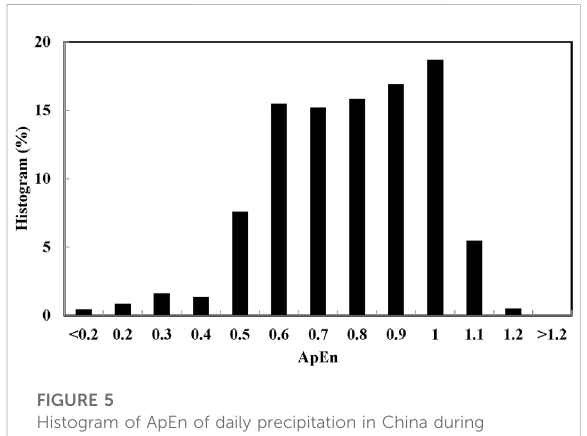
FIGURE 5 Histogram of ApEn of daily precipitation in China during 1961 – 2015.